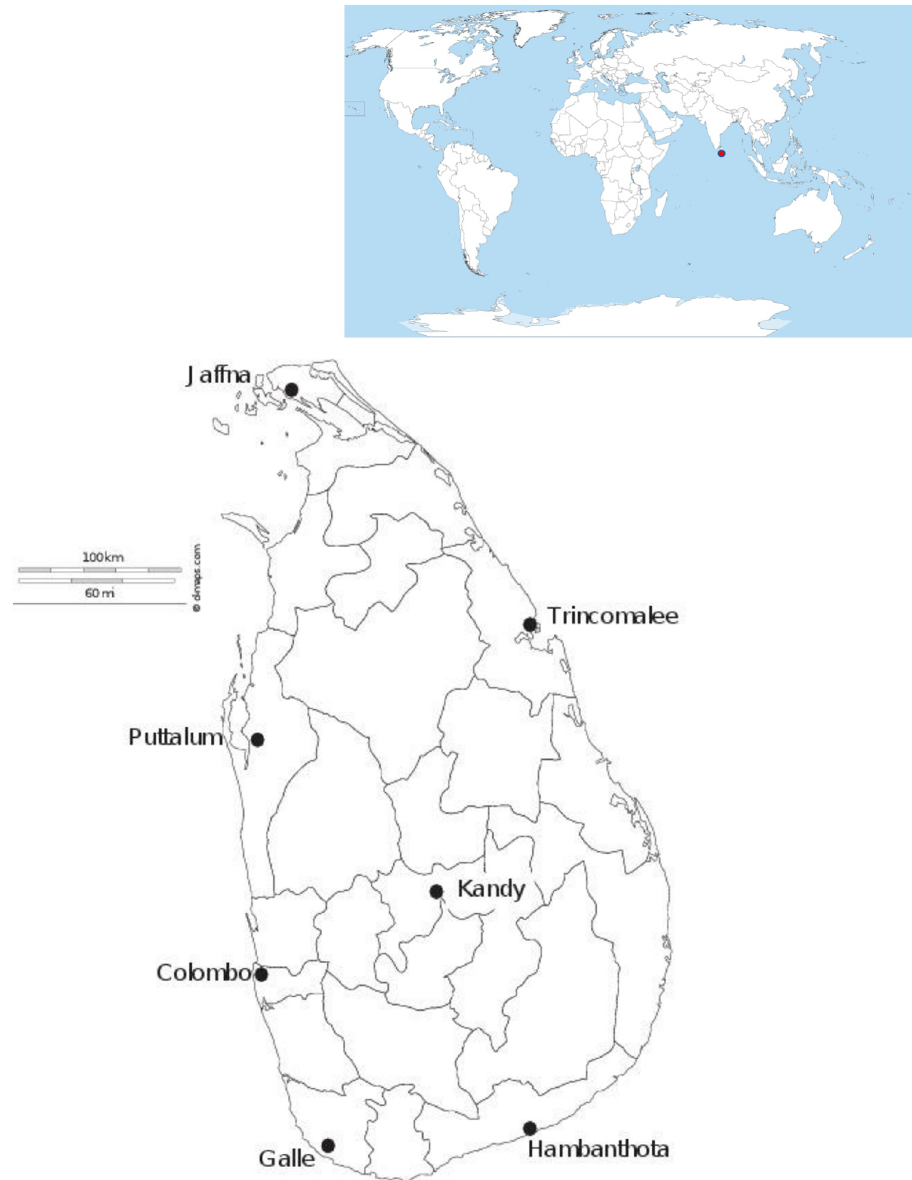
Fig 1. Map of sampling sites in Sri Lanka. The red dot on the global map indicates the geographical position of Sri Lanka in the world.